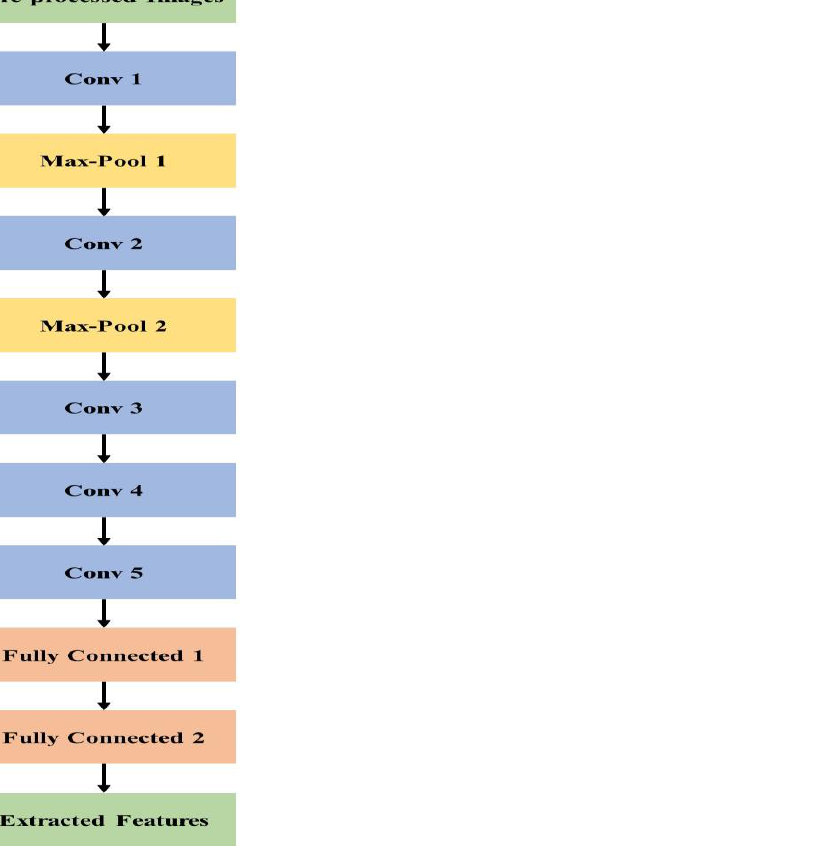
Figure 7. AlexNet model for feature extraction scene classification.